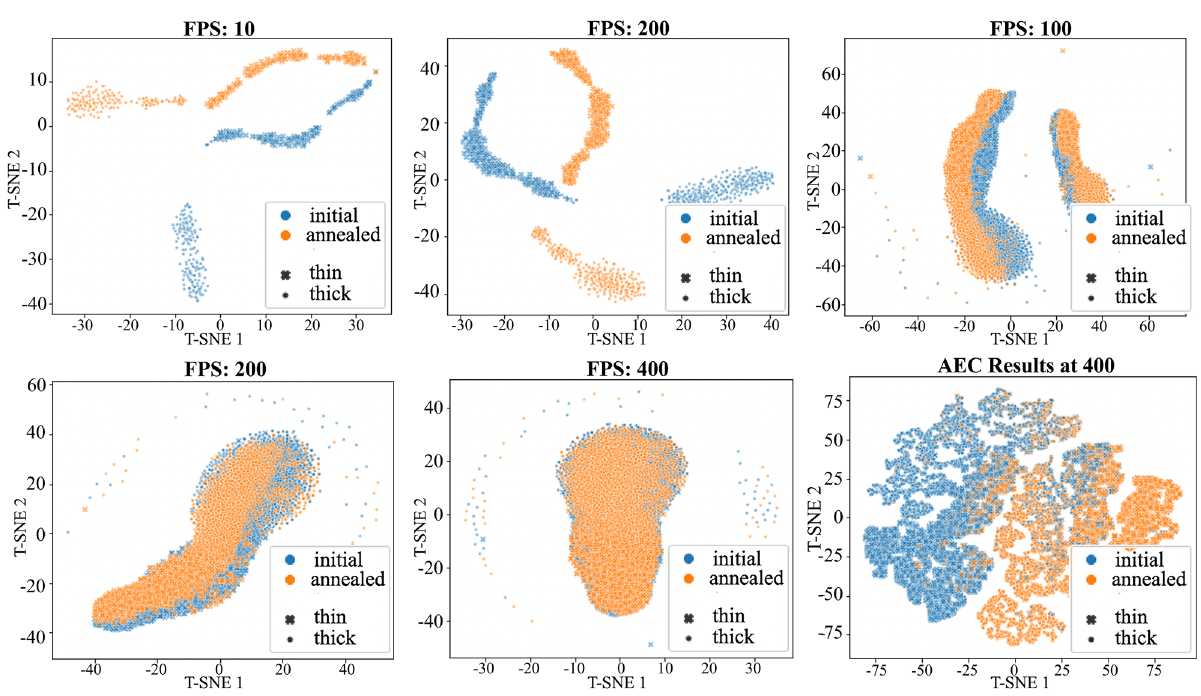
Figure 8. Two dimensional t-SNE plots of test spectra (raw data) at varied frame rates, including denoised 400 FPS spectra. Blue and orange markers represent the initial and annealed states, respectively. An ’X’ marker represents a thin sample and ’o’ marker represents a thick